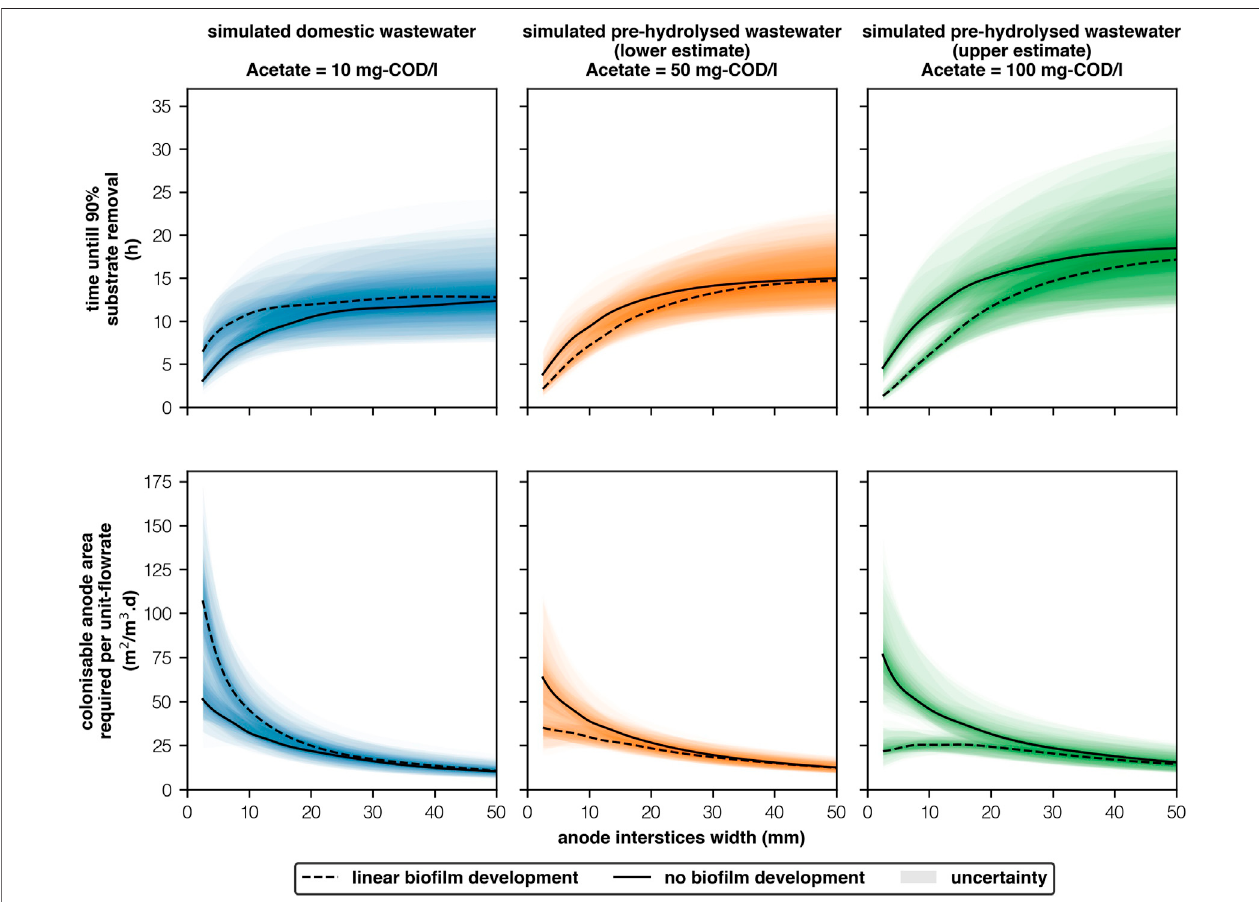
FIGURE 2 | Time until 90% substrate removal and associated anode surface area requirements per unit- fl owrate for effective treatment of simulated wastewaters with different acetate concentrations (10-100 mg-COD/l) and anode interstices widths (2.5 – 50 mm) [2 columns].